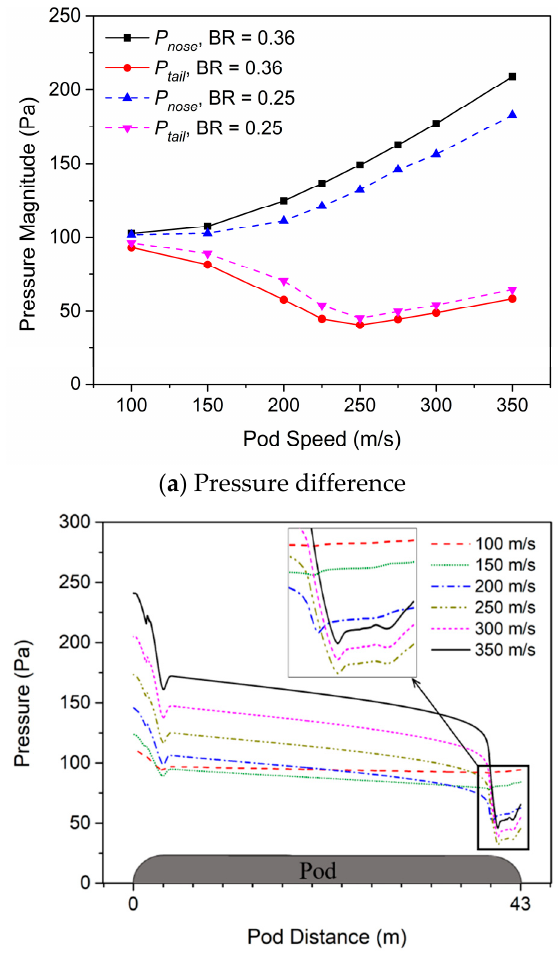
Figure 8. Pressure contours for selected pod speeds with 𝑃 (cid:3047)(cid:3048)(cid:3029)(cid:3032) = 101.325 Pa , 𝐿 (cid:3043)(cid:3042)(cid:3031) = 43 m , and ( a – e ) for BR = 0.25, ( f – j ) for BR = 0.36. Contour levels are fixed for each pod speed.